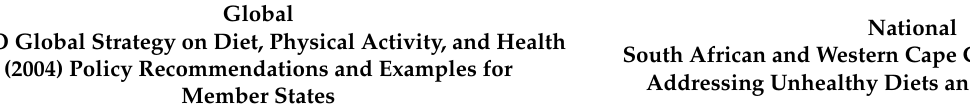
Table 3. A roadmap for action: the WHO policy proposals and where they found expression at the national/subnational